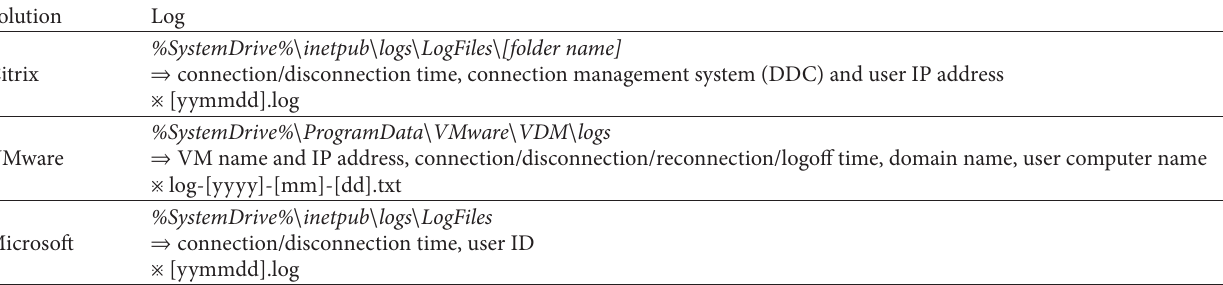
Table 5: Access information logged in the connection management system.